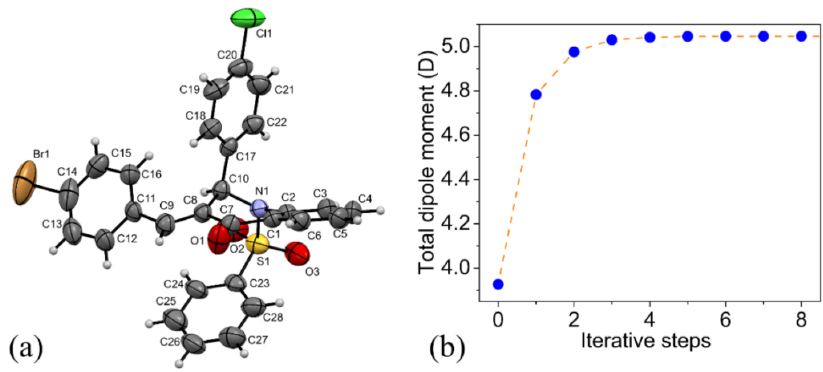
Figure 1. ( a ) The ORTEP representation of the asymmetric unit; ( b ) The total dipole moment as a function of the iterative steps for the QBCP simulated